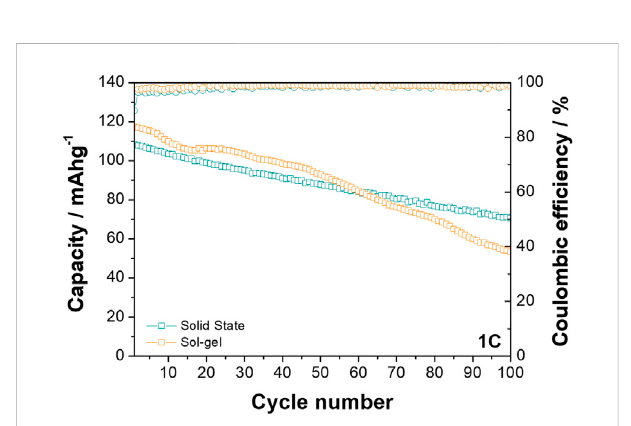
FIGURE 5 Cyclability plots of O3-NaNMFO-SS (dark turquoise) and O3- NaNMFO-SG (orange) at 1C.